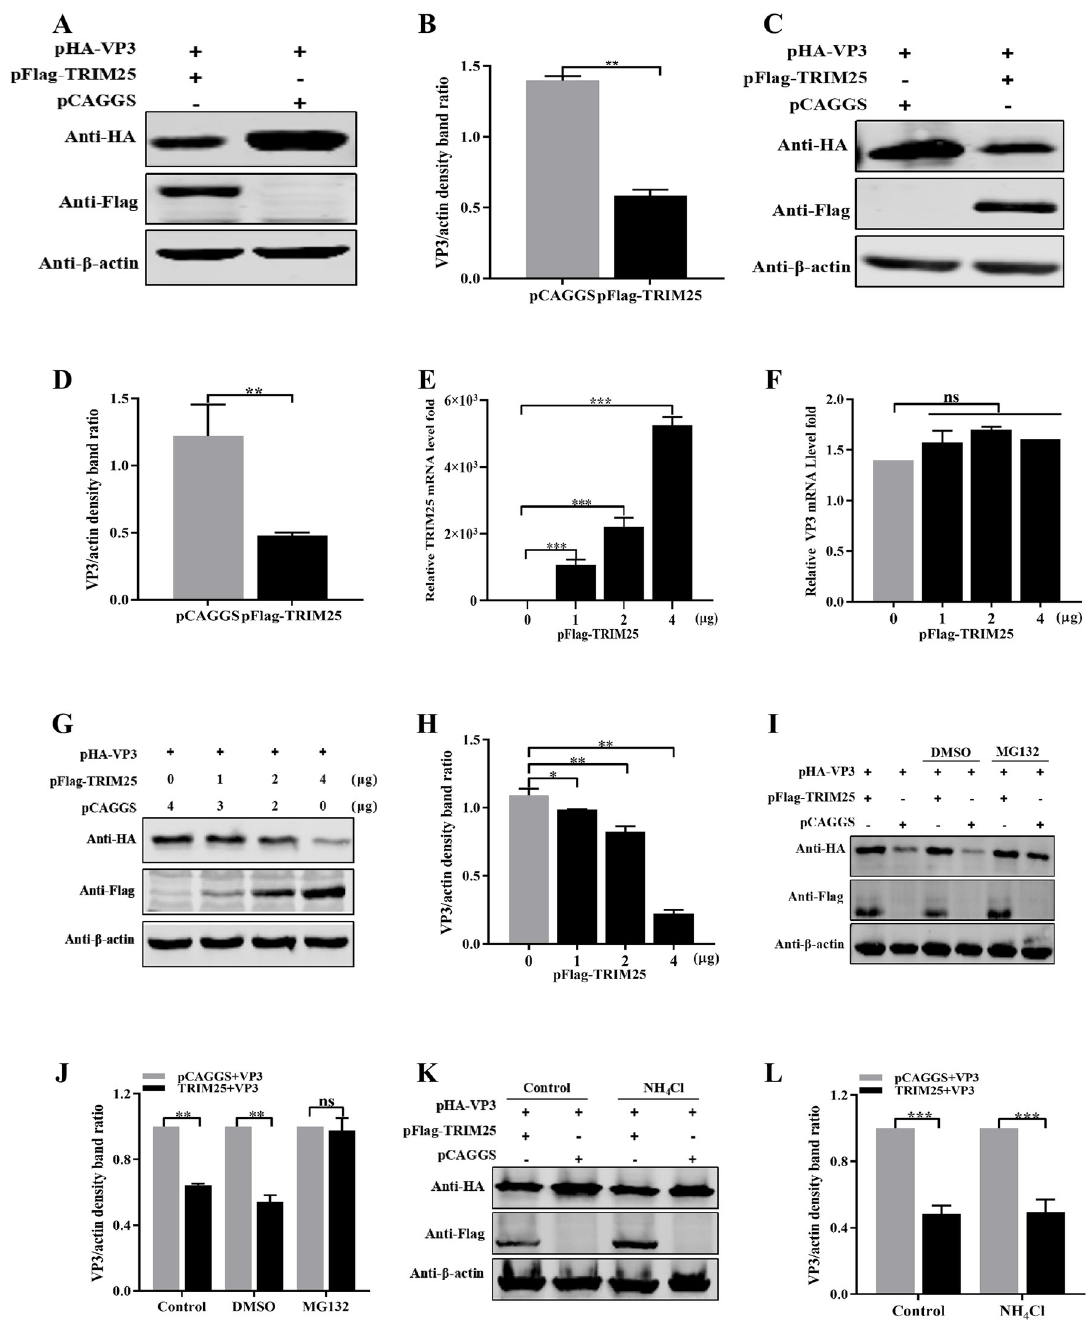
Fig 5. TRIM25 promotes the degradation of VP3 in a proteasomal way. (A-D) Exogenous expressed of VP3 was degraded by exogenously expressed TRIM25. (A and B) HEK293T cells were co-transfected with pHA-VP3 (0.5 μ g) and pFlag-TRIM25 (4 μ g) or empty vector (4 μ g) for 36 h. (A) Degradation was shown by Western blotting with the indicated antibodies. (B) Relative intensities of VP3 were normalized to β -actin. (C and D) DF-1 cells were co-transfected with pHA-VP3 (0.5 μ g) and pFlag-TRIM25 (4 μ g) or empty vector (4 μ g) for 36 h. (C) Expression levels of VP3 were determined by Western blotting using the indicated antibodies. (D) Relative intensities of VP3 were normalized to β -actin. (E-H) TRIM25 degraded the VP3 in a dose-dependent way. DF-1 cells were co- transfected with pHA-VP3 (0.5 μ g) and increasing doses of pFlag-TRIM25 (0, 1, 2, and 4 μ g) plasmids for 36 h. (E) TRIM25 mRNA levels were indicated by RT-qPCR. (F) VP3 mRNA level was indicated by RT-qPCR, and (G) Protein levels of VP3 was determined by Western blotting. (H) Relative intensities of VP3 were normalized with β -actin. (I and J) TRIM25 promoted VP3 degradation in a proteasomal way. DF-1 cells were co-transfected with pHA-VP3 (0.5 μ g) and pFlag-TRIM25 (4 μ g) or empty vector (4 μ g) plasmids for